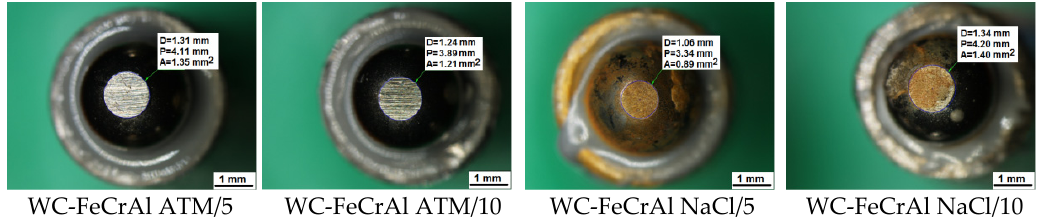
Figure 13. Pins after sliding wear test of the WC ‐ FeCrAl in dry atmosphere (ATM) and in sodium chloride (NaCl) solution.